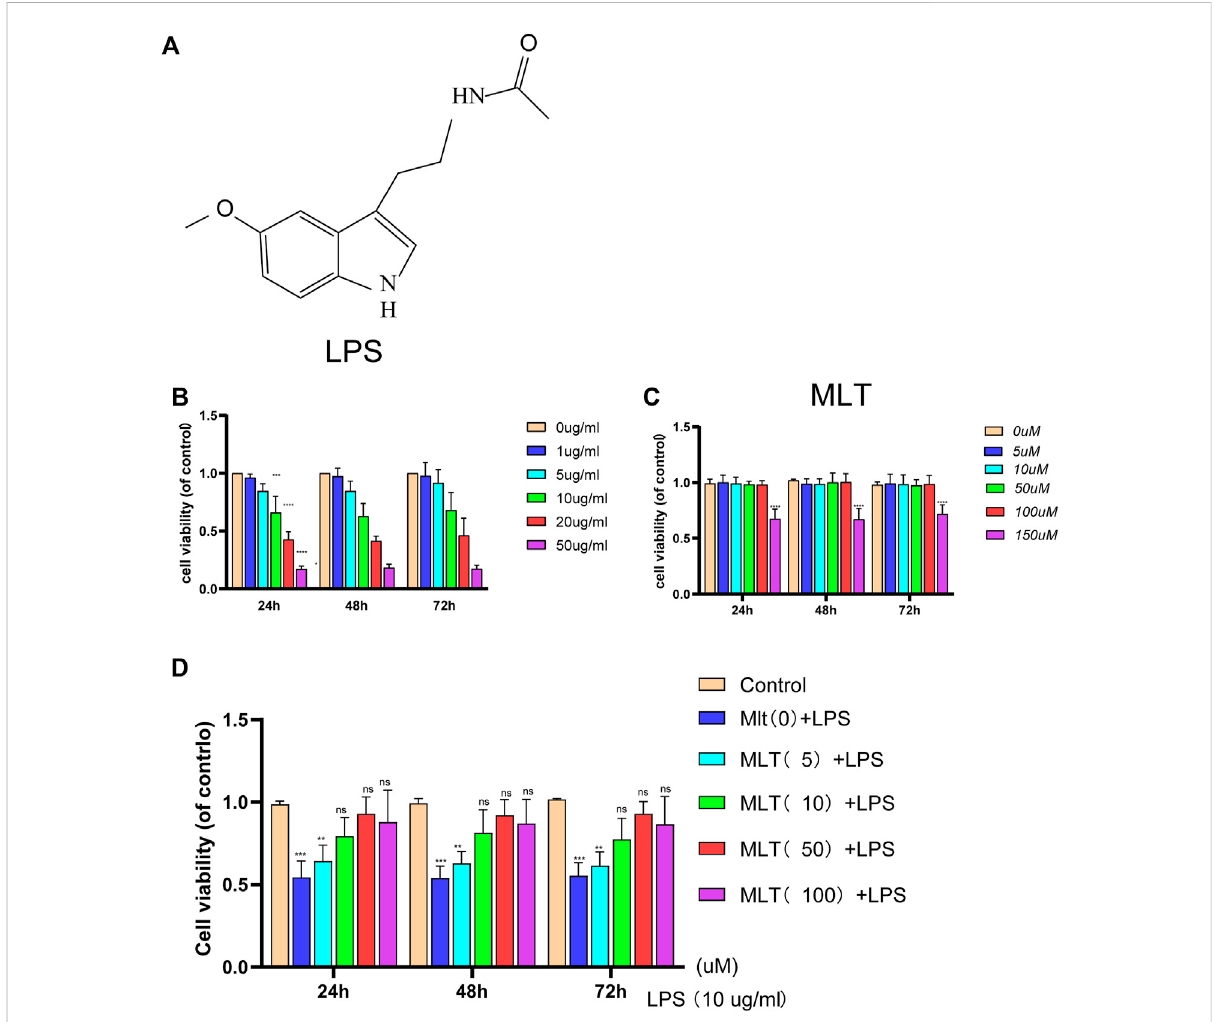
FIGURE 1 The effect of melatonin on the viability of human chondrocytes with or without lipopolysaccharide (LPS). (A) The chemical structure of melatonin. (B,C) The cytotoxicity effects of LPS and melatonin on human chondrocytes at different concentrations were tested at 24, 48, and 72 h using a cell – counting kit 8. (D) The viability of human chondrocytes treated with LPS (10 μ g/ml) after different concentrations melatonin treatment. The experiment was repeated three times independently. All values are shown as mean ± standard deviation. ** p < 0.01, *** p < 0.001, **** p